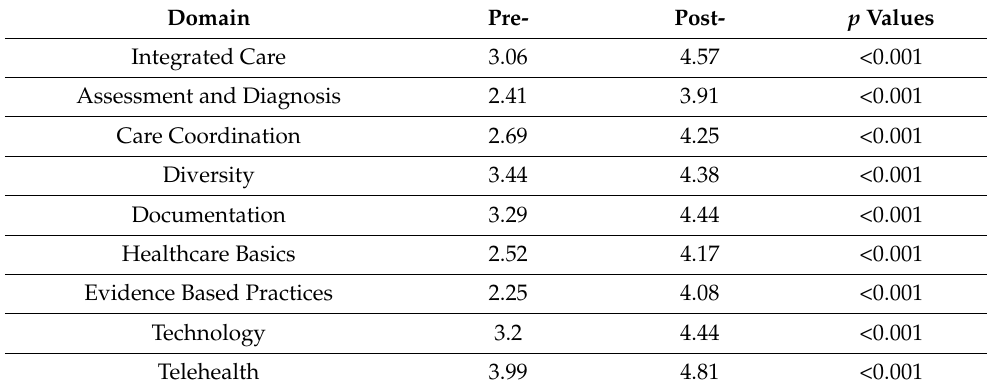
Table 2. Pre and Post Mean Scores by Student Competency Domains. Domain Pre- Post- Integrated